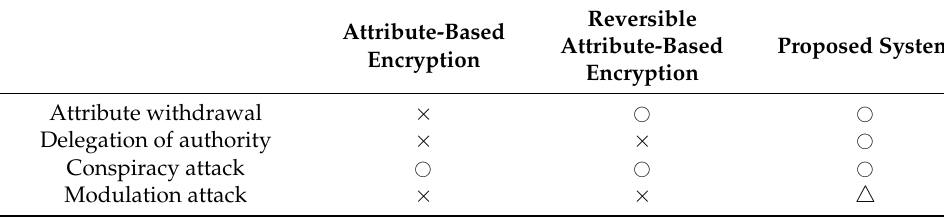
Table 2. Comparisons with the Proposed